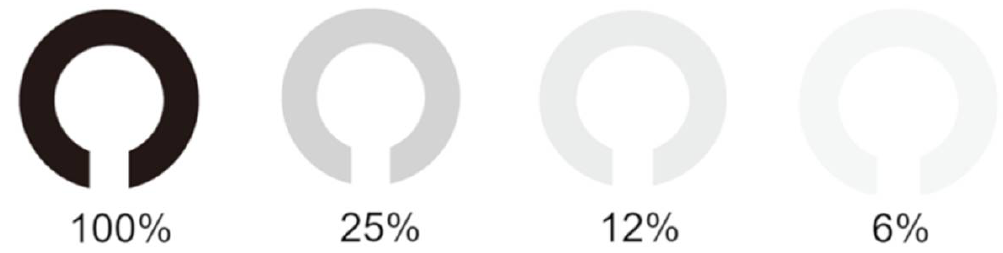
Figure 1. Contrast visual acuity charts. Depicted are low-contrast Landolt ring charts at 100%, 25%, 12%, and 6% concentrations. Table 2. Contrast visual acuities in affected and fellow eyes after reduced-fluence photodynamic therapy. VA p -Value * Index vs. 100% Concentration, % VA, visual acuity; logMAR, logarithm of the minimum angle of resolution. *, ** Wilcoxon signed-rank test. *** Mann–Whitney U test. No significant differences in the amount of changes in visual acuities were observed be- tween 25% and 12% contrast and 100% contrast between affected and fellow eyes (Table 3). Conversely, the degree of changes in visual acuities between 6% and 100% contrast was significantly greater in affected eyes than that in fellow eyes ( p < 0.05). Table 3. Amount of changes in contrast visual acuities between affected and fellow